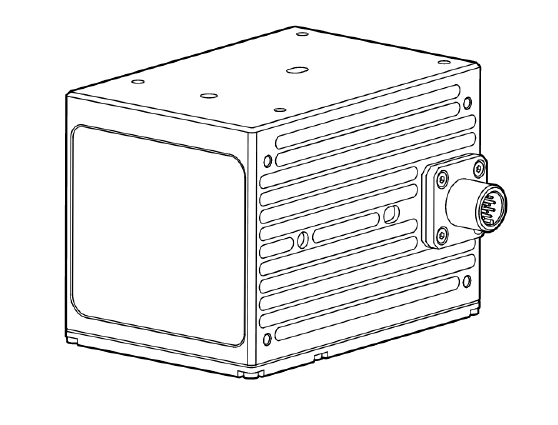
Figure 2. Schematic of the used Livox Avia Lidar sensor. The window on the left covers the sensor. (Avia User Manual, https://www.livoxtech.com,